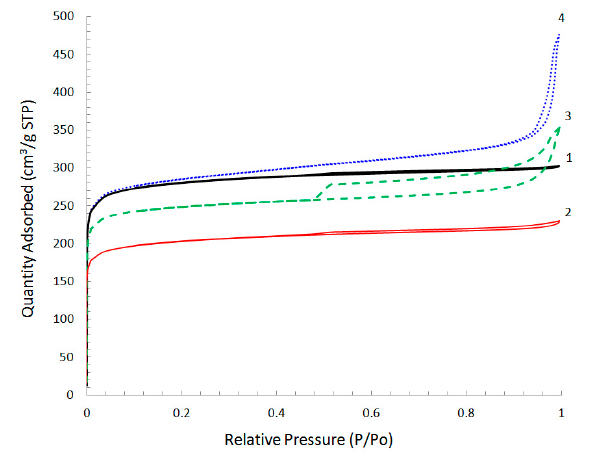
Figure 7. Low-temperature nitrogen adsorption–desorption isotherms for CM without additives (1); PCCNC with the NGC additive (2); PCCNC with the RGO additive (3); PCCNC with the GO addi- tive (4).